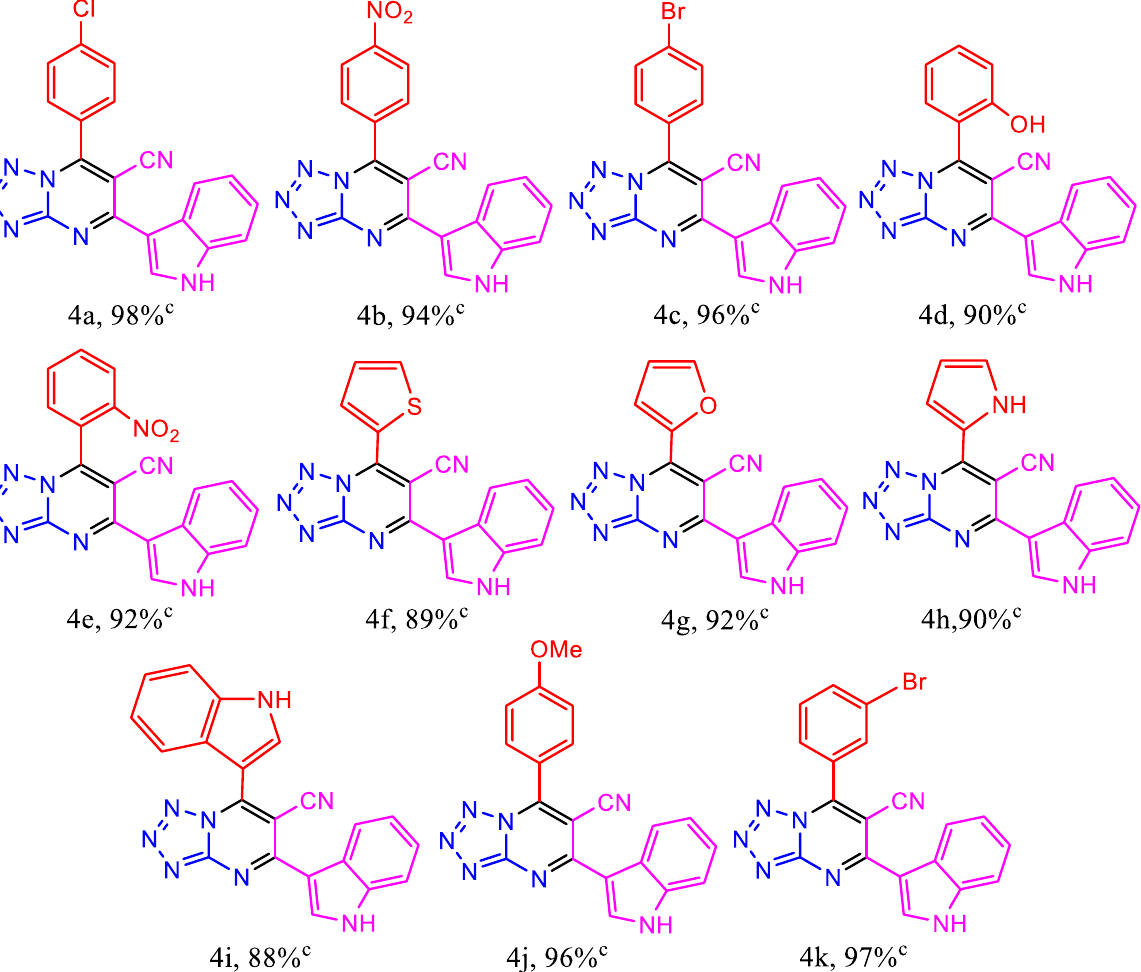
Table 3. Synthesis of tetrazolo[1,5- a ]pyrimidine-6-carbonitriles 4 catalyzed by HMTA-BAIL@MIL-101(Cr) a,b . a Reaction conditions: benzaldehydes (1 mmol), 1 H -tetrazole-5-amine (1 mmol), and 3-cyanoacetyl indole (1 mmol), HMTA-BAIL@MIL-101(Cr) (0.01 g), solvent-free, 100 °C, 15 min. b No by-products detected in 1 H NMR spectrum of the crude reaction mixtures. c Isolated yield.